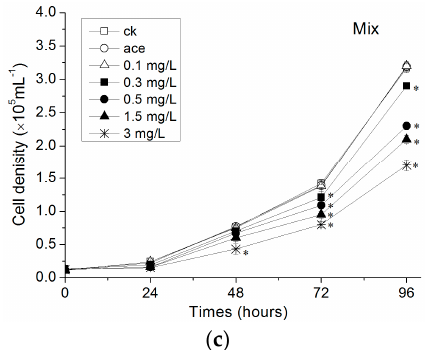
Figure 1. Effect of DES ( a ), E2 ( b ) and Mixture ( c ) treatments at concentrations on the cell number of R. subcapitata, values are the mean ± standard deviation (SD) ( n = 3). The “ck” represents control check and “ace” represents acetone treatment. An asterisk (*) indicates a value signi fi cantly di ff erent from control ( p < 0.05).